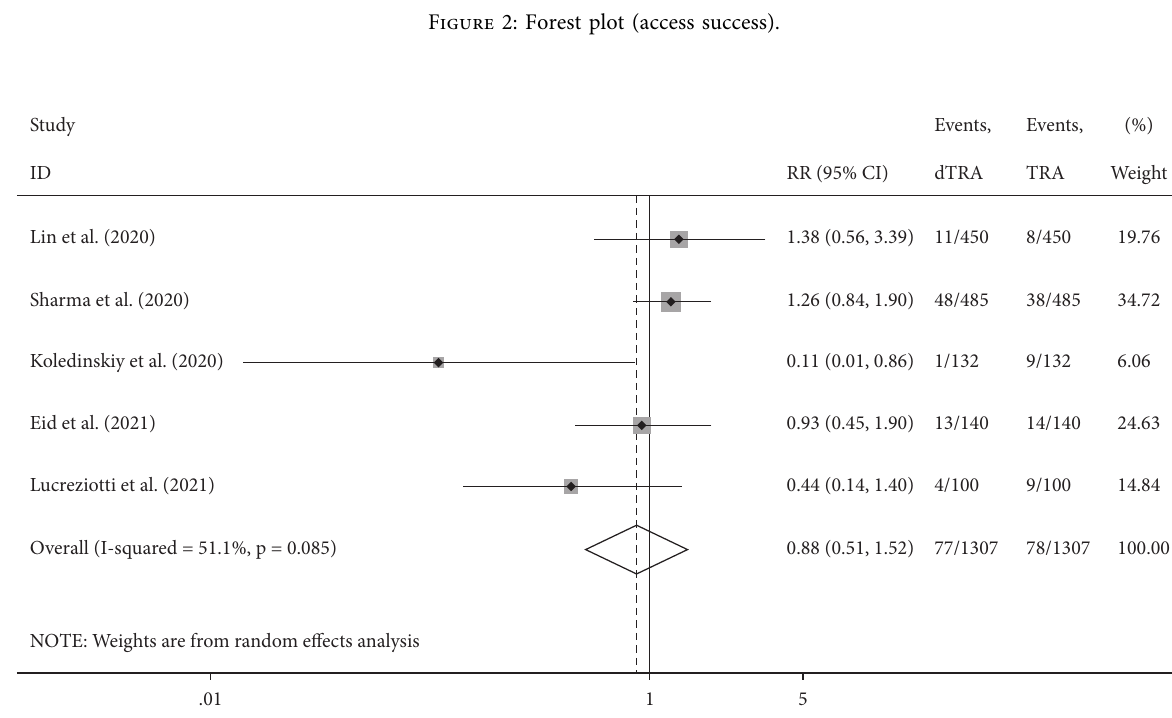
Figure 2: Forest plot (access